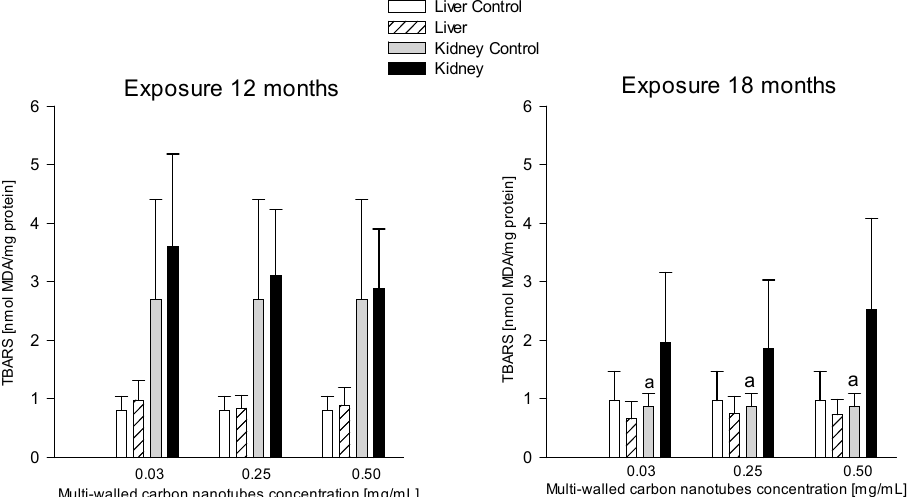
Figure 6. Comparison of thiobarbituric acid reactive substances (TBARS) concentrations in the liver and kidneys of animals exposed to multi-walled carbon nanotubes for 12 and 18 months. (a)—statistically significant difference for control group at 18 months versus control at 12 months (p = 0.025661).